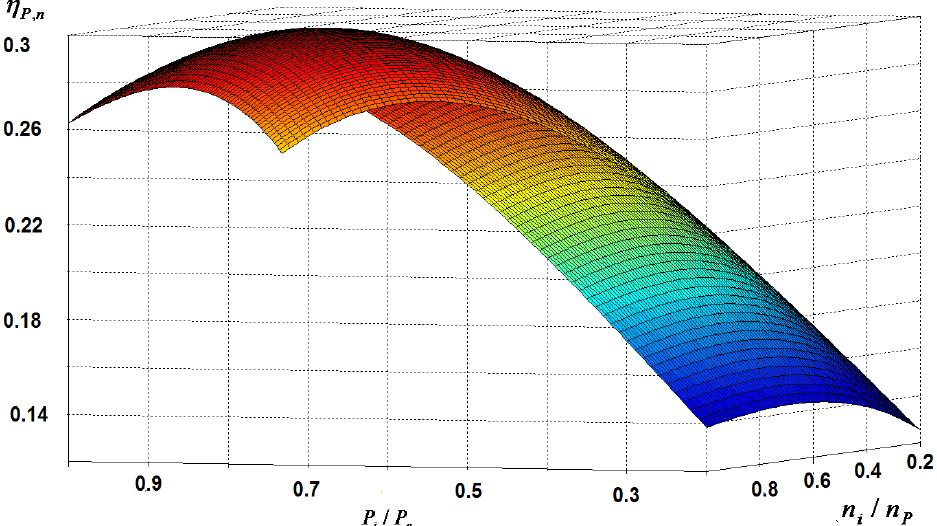
Figure 6. Gasoline engines efficiency.